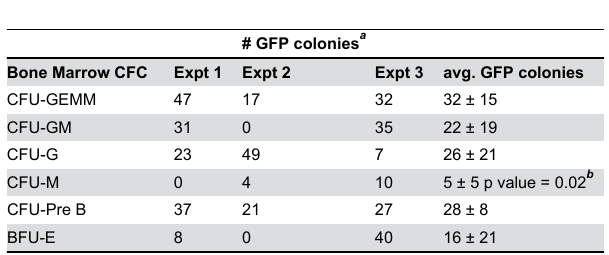
1. DSB-induced interchromosomal HR in hematopoietic progenitor cell